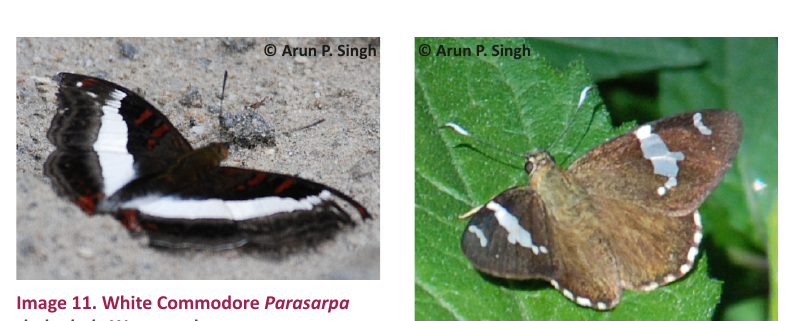
Image 12. Himalayan Spotted Flat Celaenorrhinus munda Moore